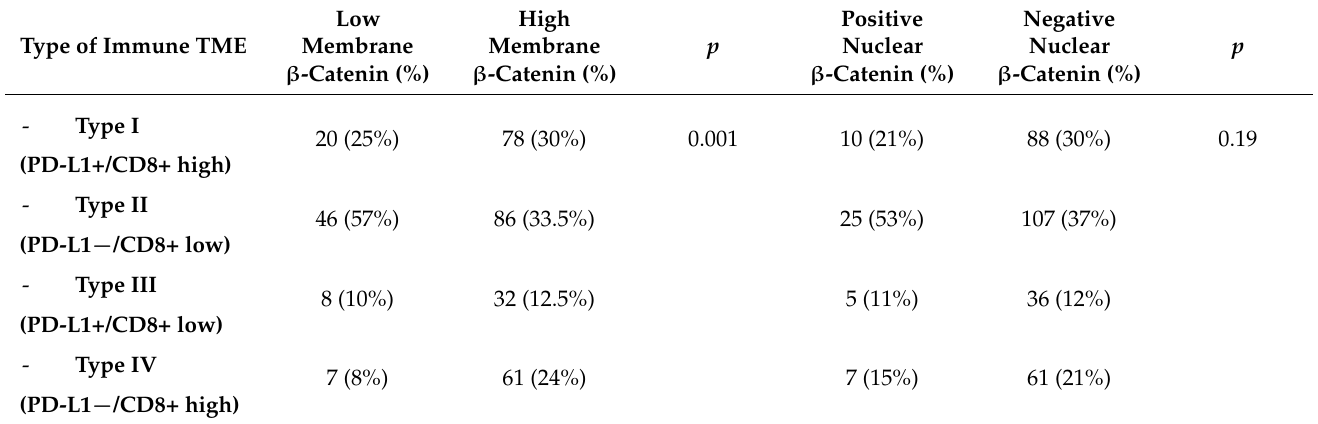
Table 2. Correlations between the type of immune tumor microenvironment (TME) and β -catenin expression.